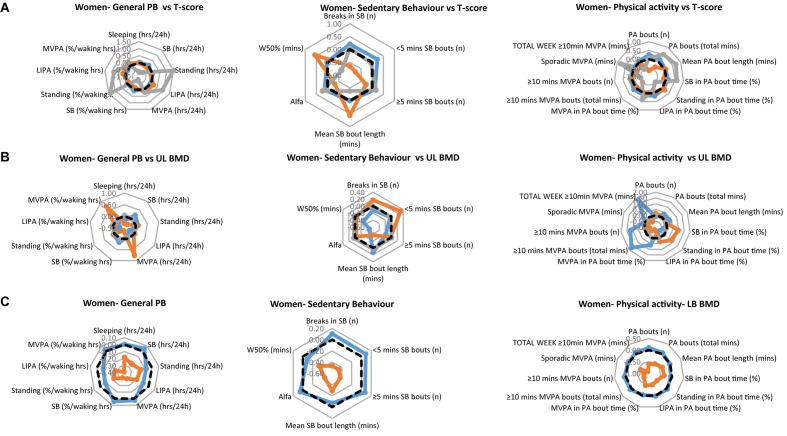
Physical behaviors (PB) in healthy (blue), osteopenic (orange), and osteoporotic (gray) women (A) as defined by the whole body T-score, (B) upper limbs BMD T-score, and (C) lower limbs BMD T-score. The radar graphs depict in separate panels (from left to right), general physical behaviors, sedentarism-specific behaviors, and physical activity-specific behaviors. Sample mean is shown in a black dashed line. PB data shown are computed Z-scores.